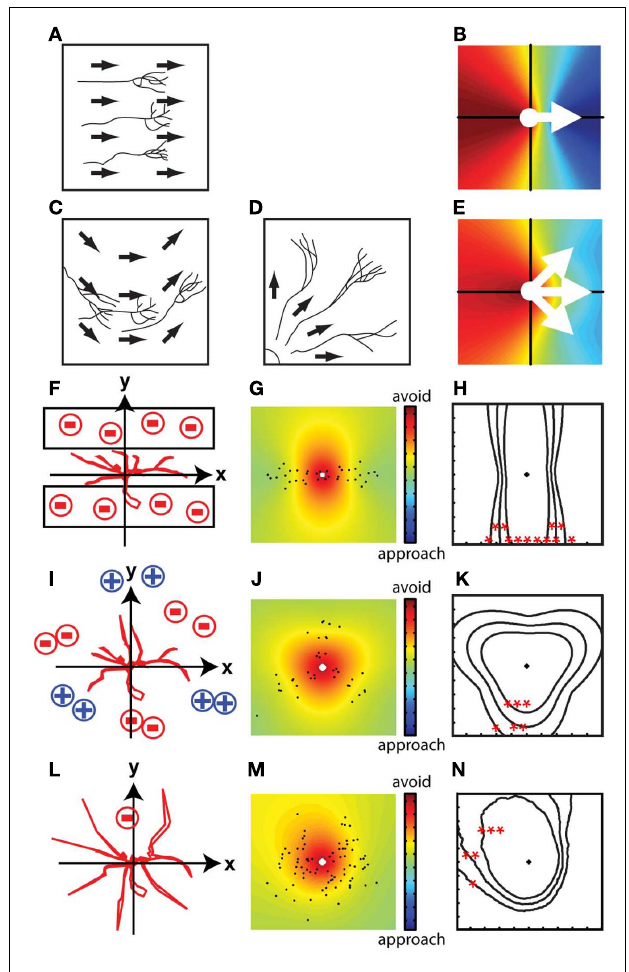
FIGURE 3 | Spatial maps of virtual growth patterns. Simplified conditions in which all of the branches are guided by linear gradients of guidance cues (A,B) and cues distributed in non-linear patterns (C–E). If branches move in the same directions due to the linear gradient of cues (A) , the steepness of the changes in the color representation of displacements is greater and form relatively straight lines (B) . If the gradient of the guidance cue is curved (C) or branches extend away from a focal point in the tissue (D) , the changes in color are curved in the map (E) . (F–N) Displacement vector maps of the virtual situations in Figures 1A,C,E in which the mean of the displacement vectors did not provide directional information. Contour lines of p -values are shown as follows: * p < 0.05, ** p < 0.01, *** p < 0.001. When neurites grow in a small stripe (F) , the displacement vector map and the p -values represent contour lines surrounding a hot color region perpendicular to the restricted directions of growth (G,H) .This map indicates that the movement of branches is more restricted along the vertical axis than horizontal axis. Spatial information can also be extracted when the growth of neurites is point symmetric (I–K) or when branches avoid a small region in the tissue (L–N) .The asymmetric shape of the contour line shows the spatial asymmetry of the avoidance